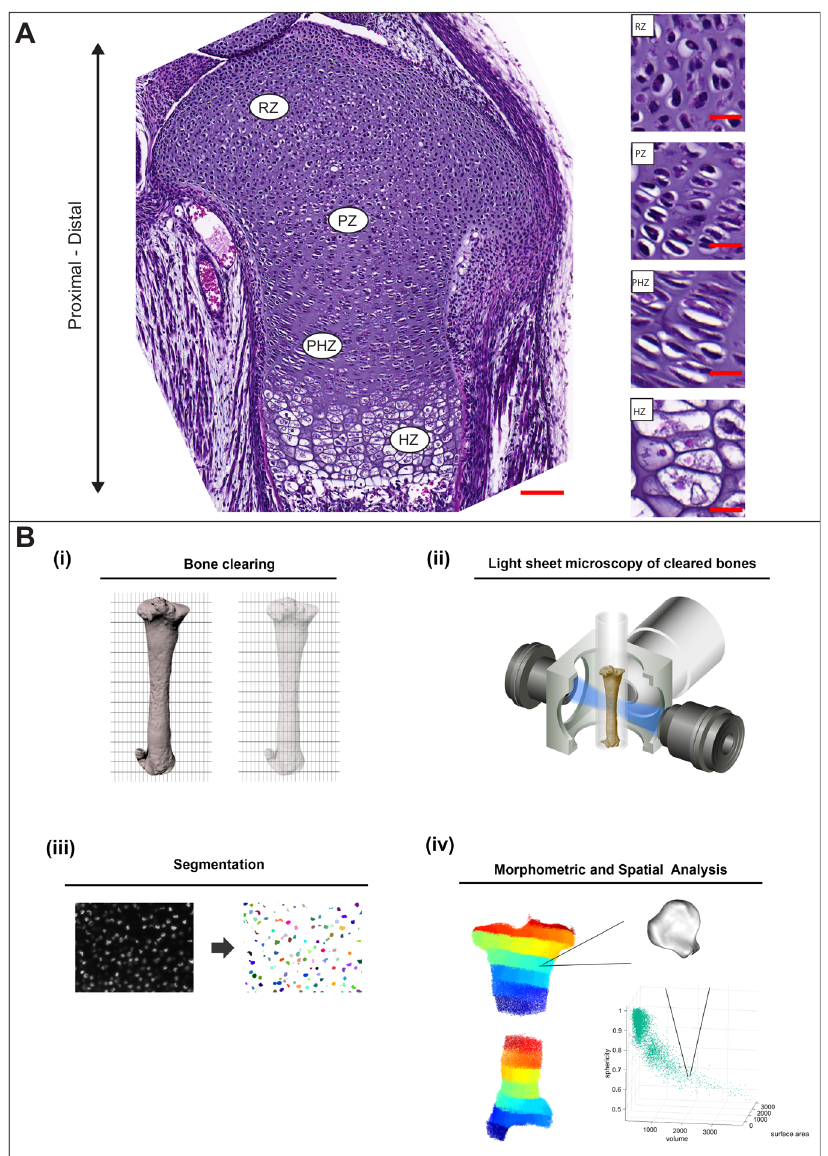
Fig. 1 3D MAPs: morphometric analysis to test for phenotypic signi fi cance. A 7 µ m-thick paraf fi n sections of an E18.5 proximal tibial growth plate stained with H&E show the typical four zones of the growth plate along the proximal-distal axis of the bone. Scale bar: 100 µ m. The magni fi ed images on the right show the morphological changes of chondrocytes during their differentiation sequence, including fl attening and column formation of proliferative zone (PZ) chondrocytes, enlargement of column cells in the prehypertrophic zone (PHZ) and increase in size of terminally differentiated chondrocytes in the hypertrophic zone (HZ). Scale bars: 20 µ m. B An overview of 3D MAPs pipeline. (i) The bone is dissected and cleared by PACT-deCAL, and nuclei are fl uorescently labeled. (ii) The cleared bone is embedded in a glass capillary and proximal and distal growth plates are imaged at high-resolution with a Z.1 light-sheet microscope. (iii) Each image stack undergoes nuclear and cellular segmentation. (iv) The segmented cells and nuclei are subjected to morphometric analyses and are projected back onto their anatomical position in the